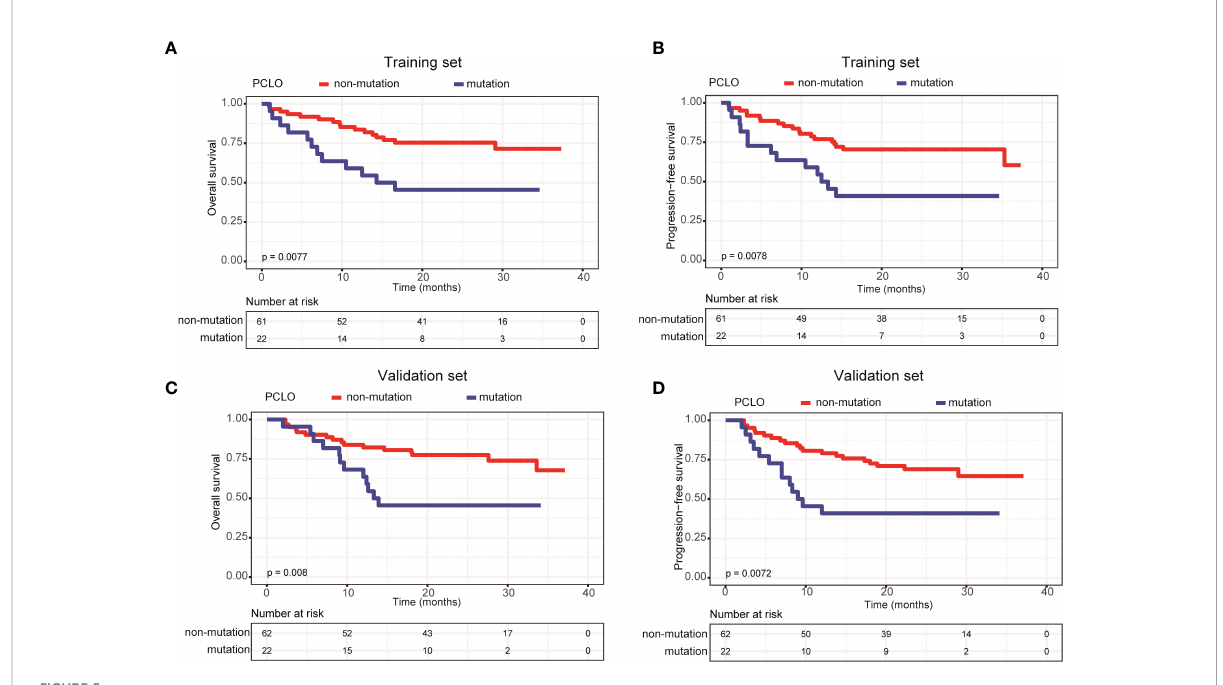
FIGURE 5 Patients carrying PCLO mutations trended to have poor prognosis. Kaplan-Meier curves were applied to compare the (A) OS and (B) PFS between patients with and without PCLO mutations in the training set. Kaplan-Meier curves were applied to compare the (C) OS and (D) PFS between patients with and without PCLO mutations in the validation set.